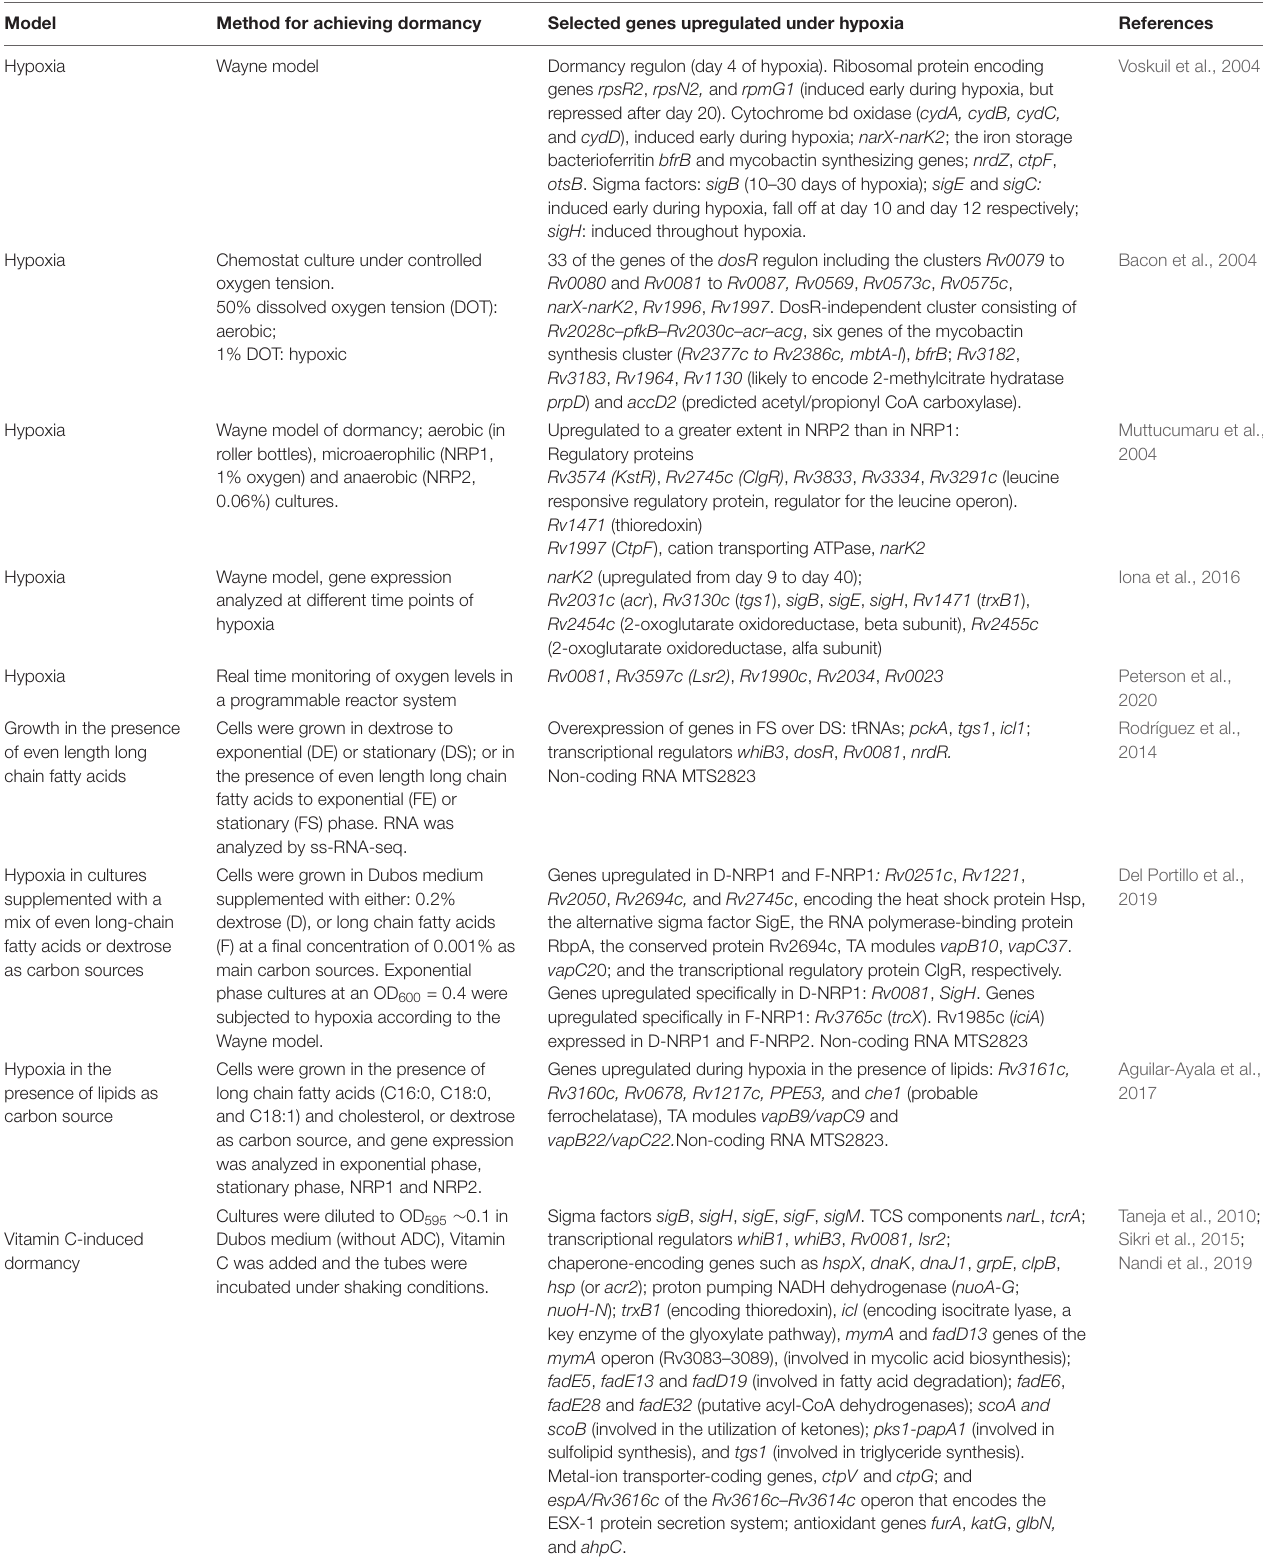
TABLE 1 | Mycobacterium tuberculosis genes upregulated in various in vitro models of dormancy.